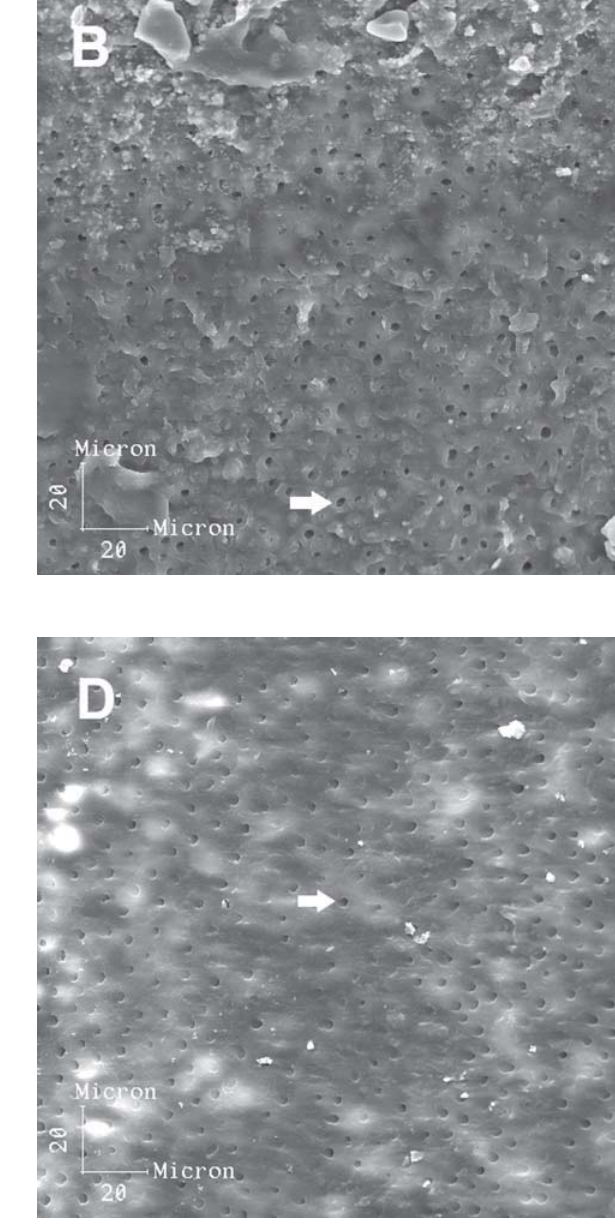
FIGURE 1- Representative SEM micrographs of samples from the middle root third: A) Control, B) Chloroform, C) Eucalyptol, D) Orange oil. Note the presence of only few open dentinal tubules (arrows). Original magnification X500